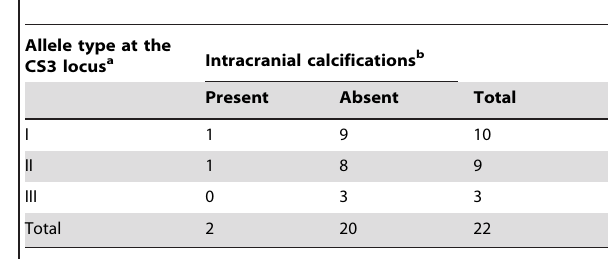
Table 5. Association between the allele type at the CS3 locus of Toxoplasma gondii isolate and intracranial calcifications in newborns with congenital toxoplasmosis (p .